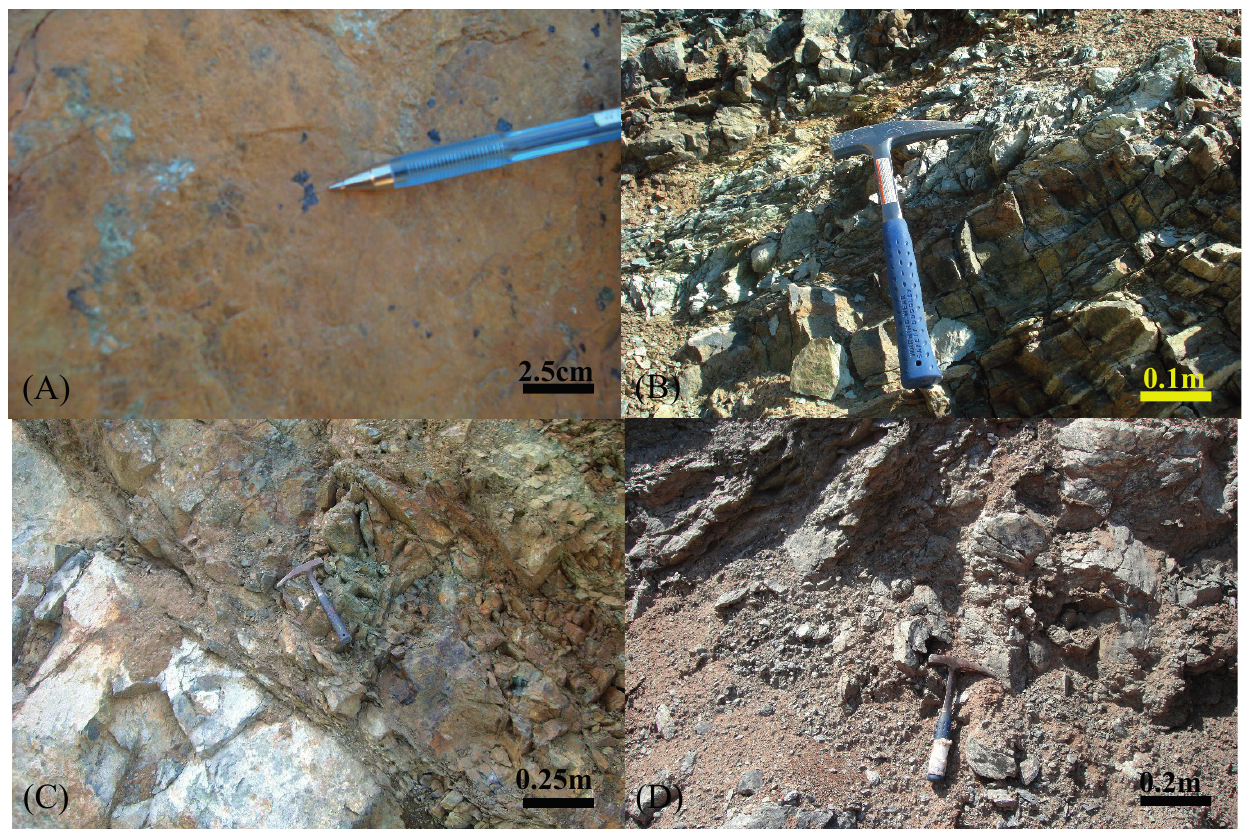
Figure 12. ( A ) Coarsly crystalline chromite within dunite host rocks at field checkpoint no. MD1; ( B ) Dikes of acidic rocks (plagiogranite) intruded dunite host rocks, sample no. P nearby sample no. MD1; ( C ) gabbro rocks sample no. SJ; ( D ) Serpentine in Walash, Sample no. M1.